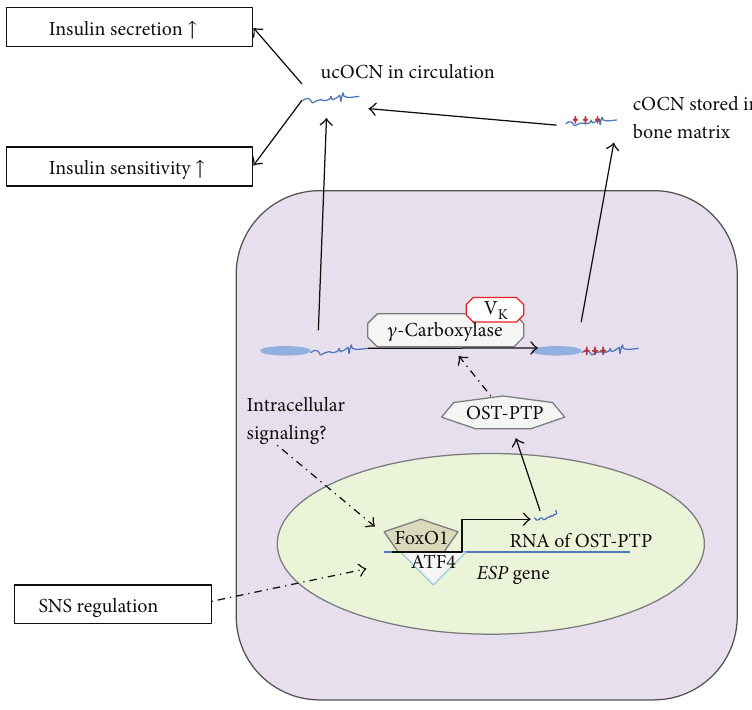
Figure 4: Proposed regulation of Esp expression and OCN carboxylation in mice. FoxO1 and ATF4 could bind to the promoter site to stimulate the transcription of Esp . The product of Esp is OST-PTP, which can suppress the carboxylation of prepro-OCN and in turn suppress the activity of OCN. V K , Vitamin K; SNS, sympathetic nervous system; OCN, osteocalcin; ucOCN, uncarboxylated